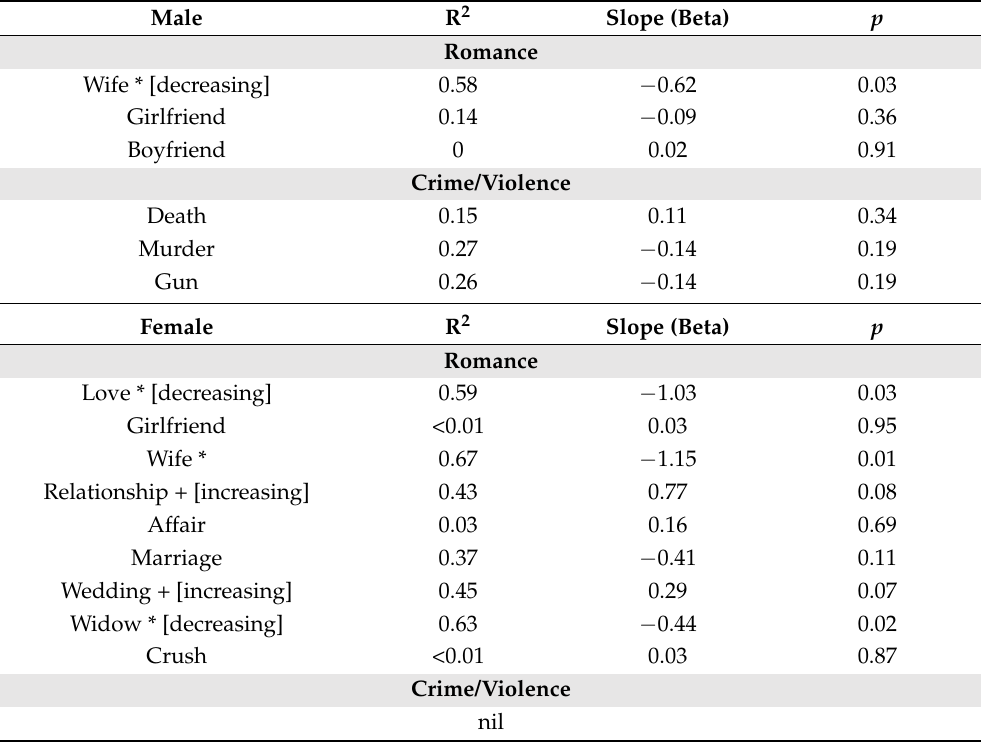
Figure 8. Needle plot representing edge weights of the twenty most significant primary noun associations of male characters ( top ) and female characters ( bottom ). Table 3. Linear regression analysis of edge weight regressed on decade for stereotypical nouns. * p < 0.05, + p < 0.10.